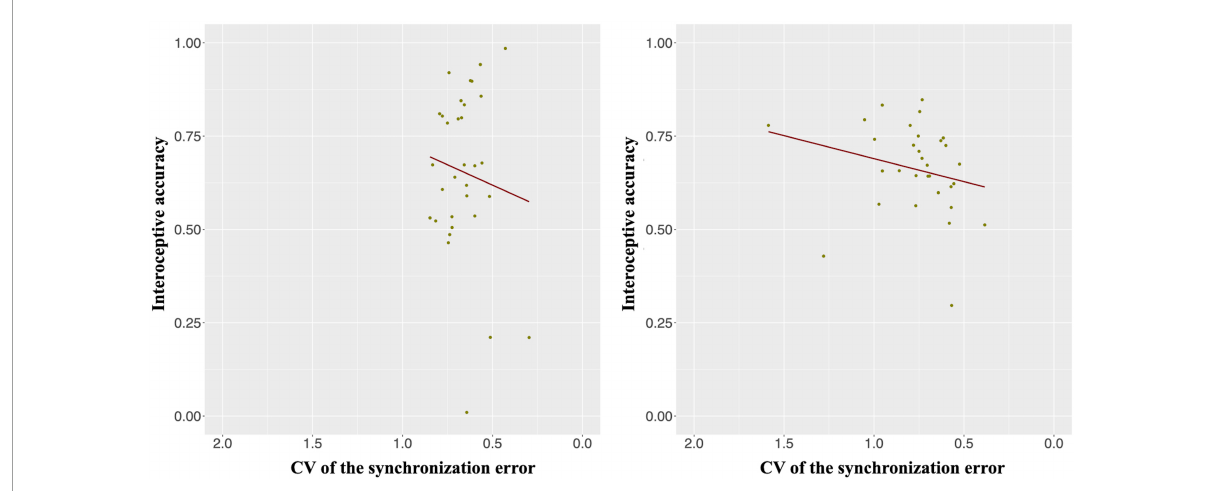
FIGURE4 Interoceptive accuracy (IAcc) was positively correlated with the CV of the synchronization error in only the slow tempo ( right panel ; r = 0.46, p < 0.05) but not the normal tempo ( left panel ; r = 0.12, p = 1.00) condition. Inverting the values on the x -axis indicates that the farther the value is to the right, the higher the participant’s performance (lower